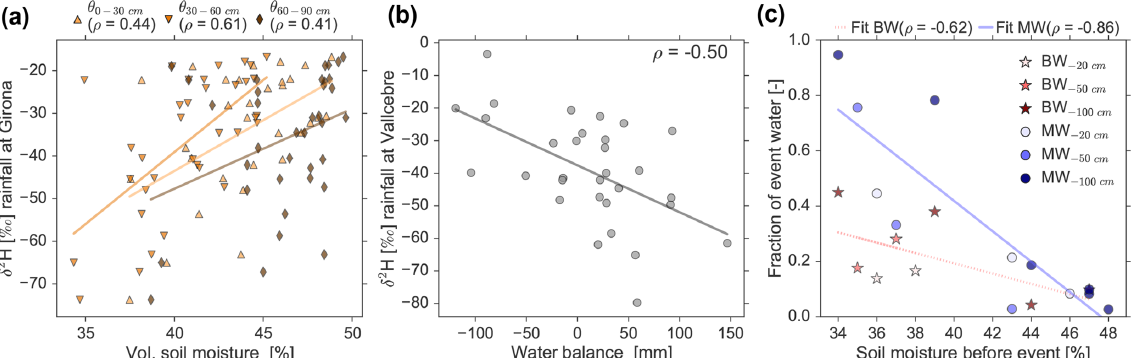
Figure 6. Relationships between wetness and rainfall stable isotopes and refilling of soil pores. (a) Monthly rainfall stable isotopes (GNIP data) are more depleted when soils are drier. (b) Monthly rainfall at the study site is more depleted when monthly rainfall volumes are higher than potential evapotranspiration (positive water balance). (c) Fraction of newly infiltrated water (derived from mass balance) is higher when soil moisture was low before the infiltration event. All relationships ( ρ shows Spearman rank correlation coefficients) are significant ( p < 0 . 05) with the exception of Fit BW (dashed red line), for which p = 0 .